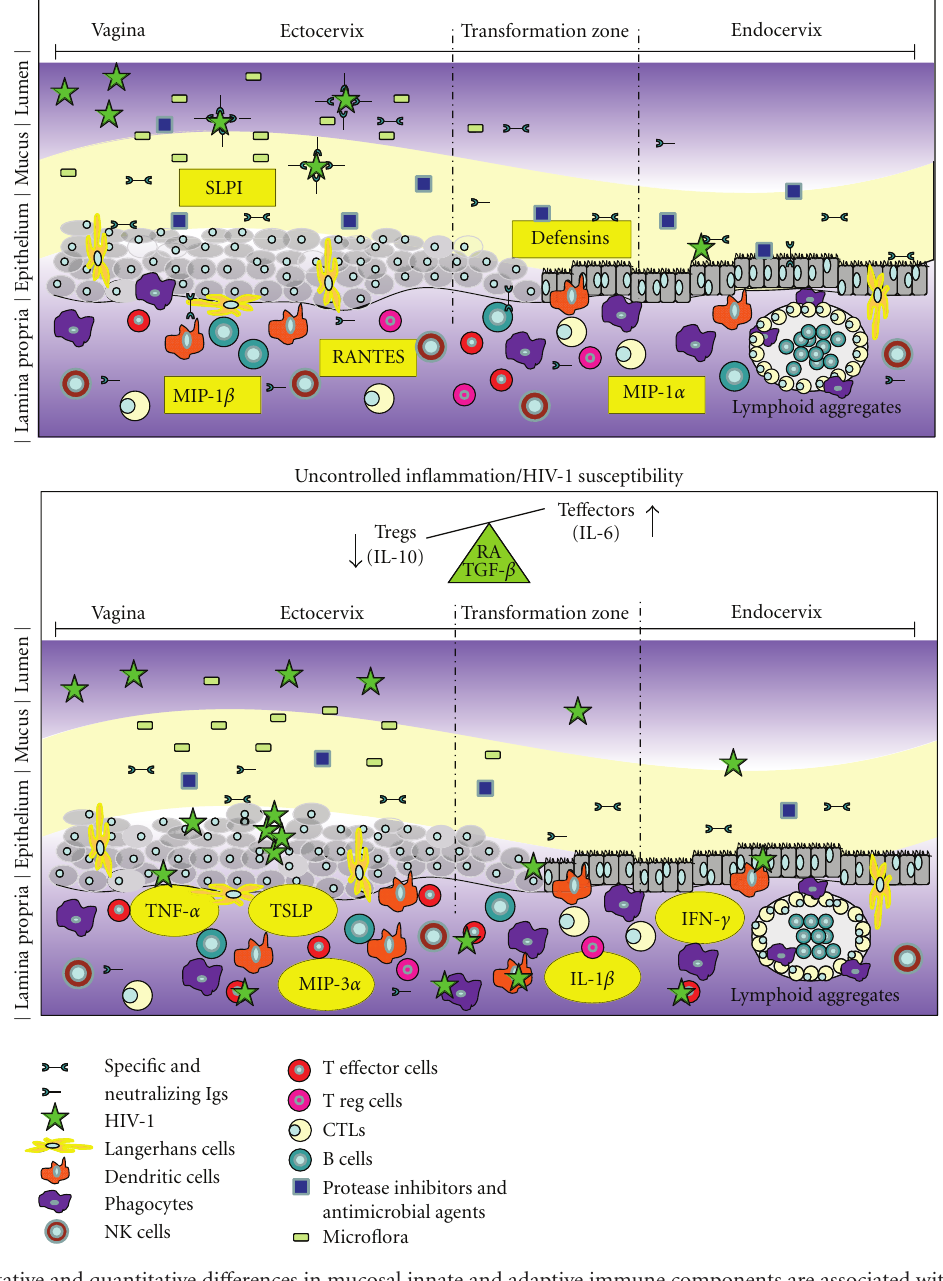
Figure 1: Qualitative and quantitative di ff erences in mucosal innate and adaptive immune components are associated with the outcome of HIV infection in the female genital tract